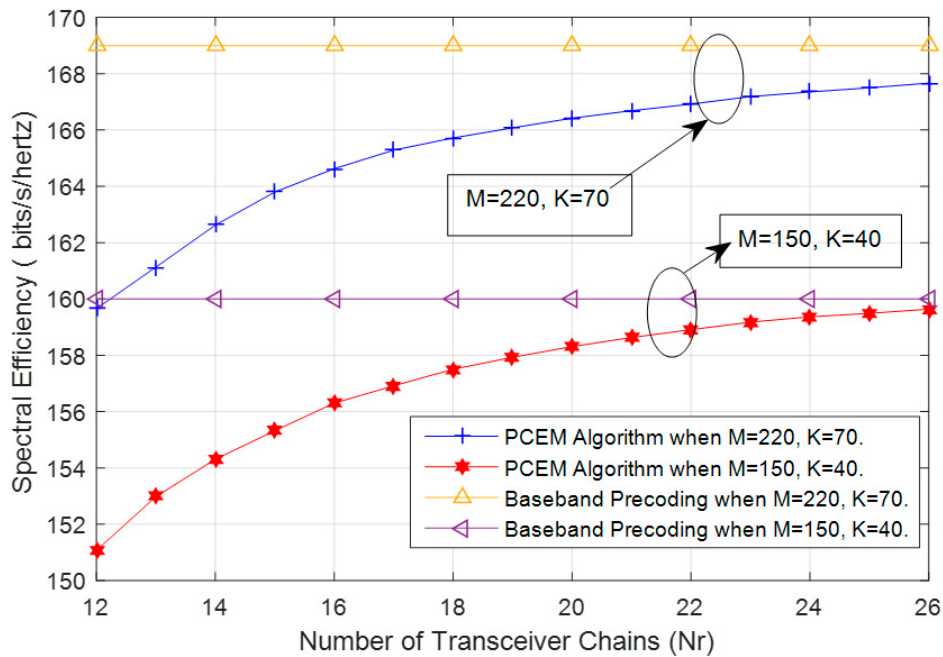
Figure 4. E ff ects of the number of transceiver chains on the spectral e ffi ciency.